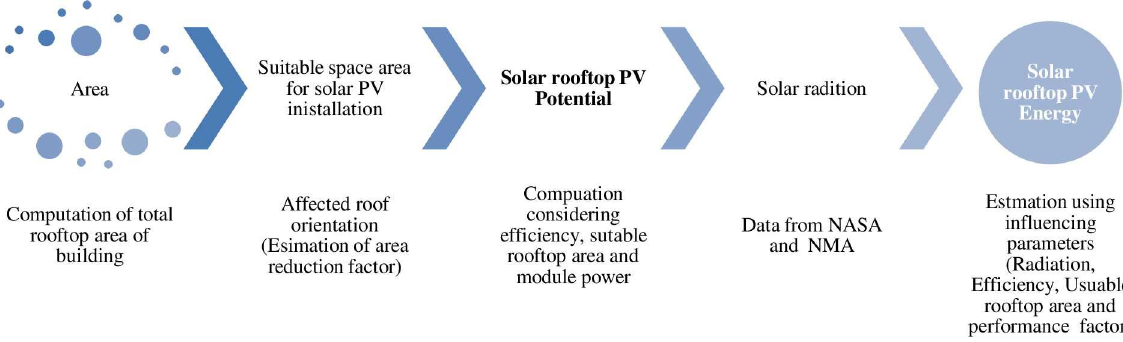
Fig 6. Schematic of methodology PV potential